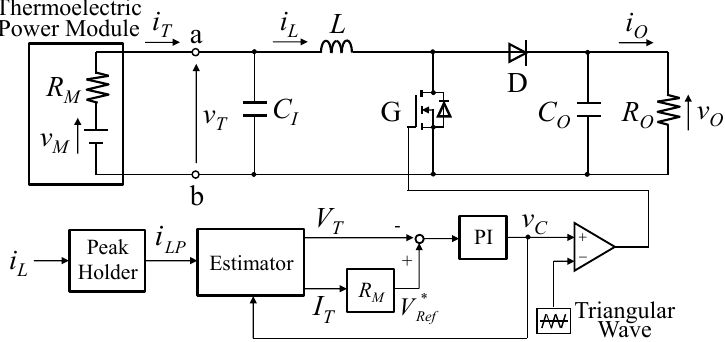
Figure 6. A circuit diagram with the proposed MPPT control method.